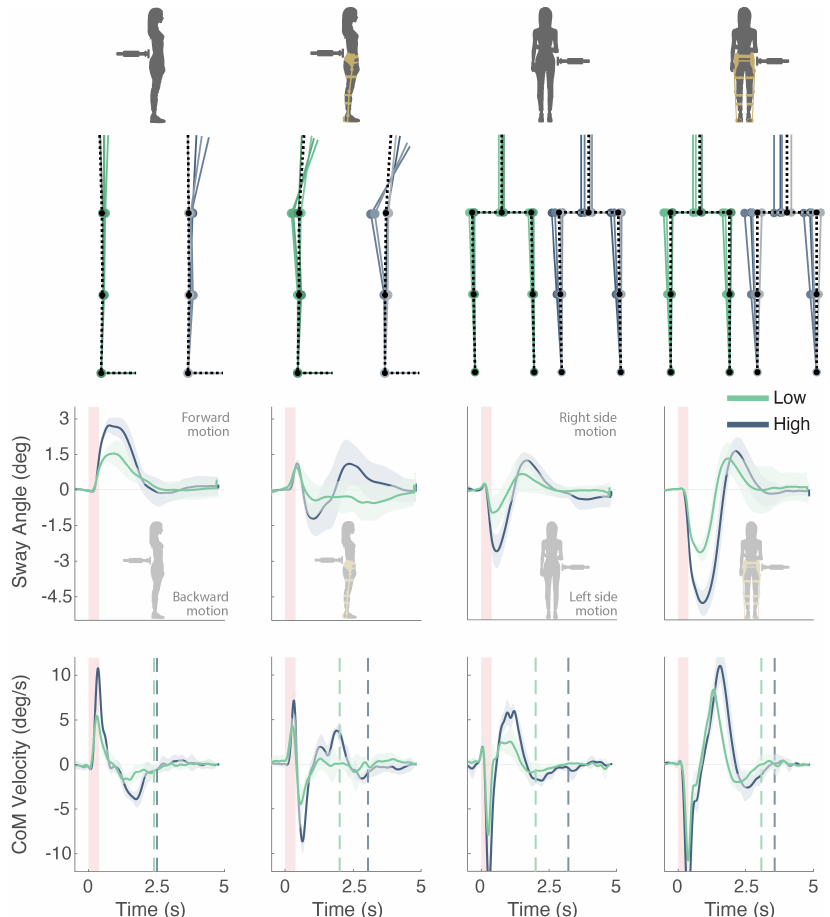
Figure 9. Example of participant’s performance in two scenarios (not wearing and wearing the exoskeleton) and four perturbation conditions (mid back—Low and High, and right side torso— Low and High). In all figures, the mean ± SD across the five adequate perturbations applied for each condition are presented, with responses to Low perturbations in green, and responses to High perturbations in blue. The stick diagrams of the first row simulate the averaged movement performed by the participant and exoskeleton in each condition. The second and third row show the time-series data of body sway angle and CoM velocity respectively, which are used to calculate the BIs. The onset and duration of the provided perturbations are indicated by the red vertical areas, while the vertical dotted lines represent the recovery times for each